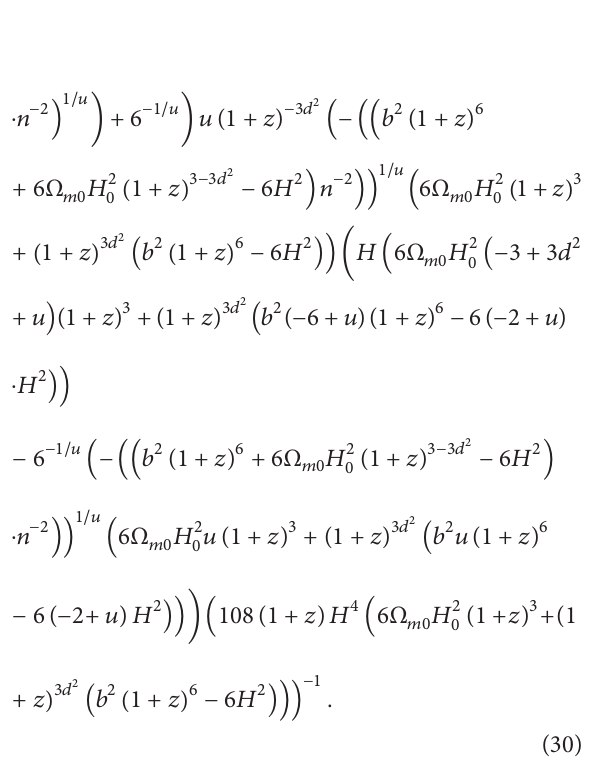
Figure 2: Plots of 𝜔 𝜗 versus 1 + 𝑧 for Hubble horizon PDE model in dynamical Chern-Simons gravity with 𝑢 = 2, 1,−1, −2 .